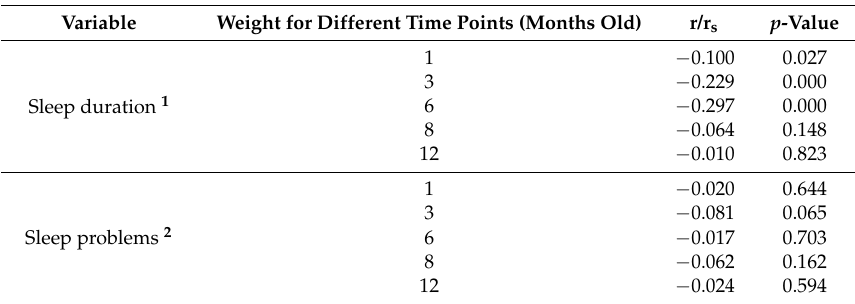
Table 4. The correlation of infant sleep duration and sleep problems with infant weight across five time points based on panel data (According to longitudinal community-based retrospective birth cohort study conducted in Changsha in